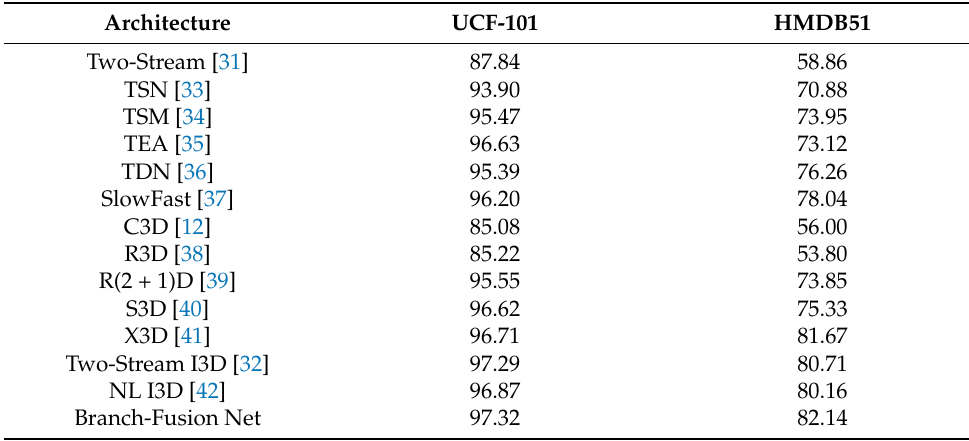
Table 6. Accuracy (%) comparison on UCF-101 and HMDB datasets.